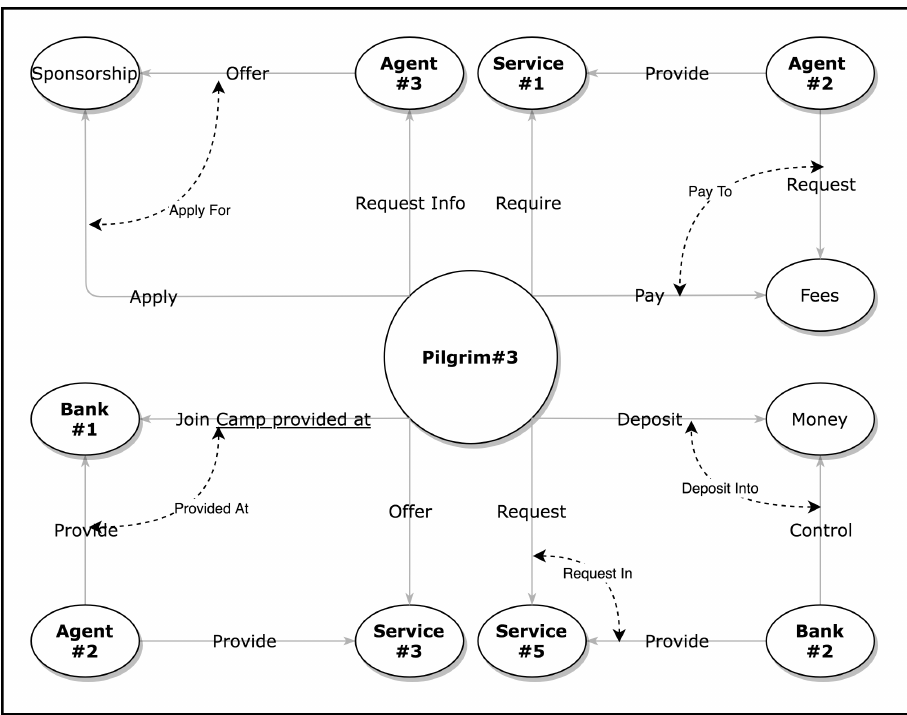
Figure 6. Part of the lexicon domain